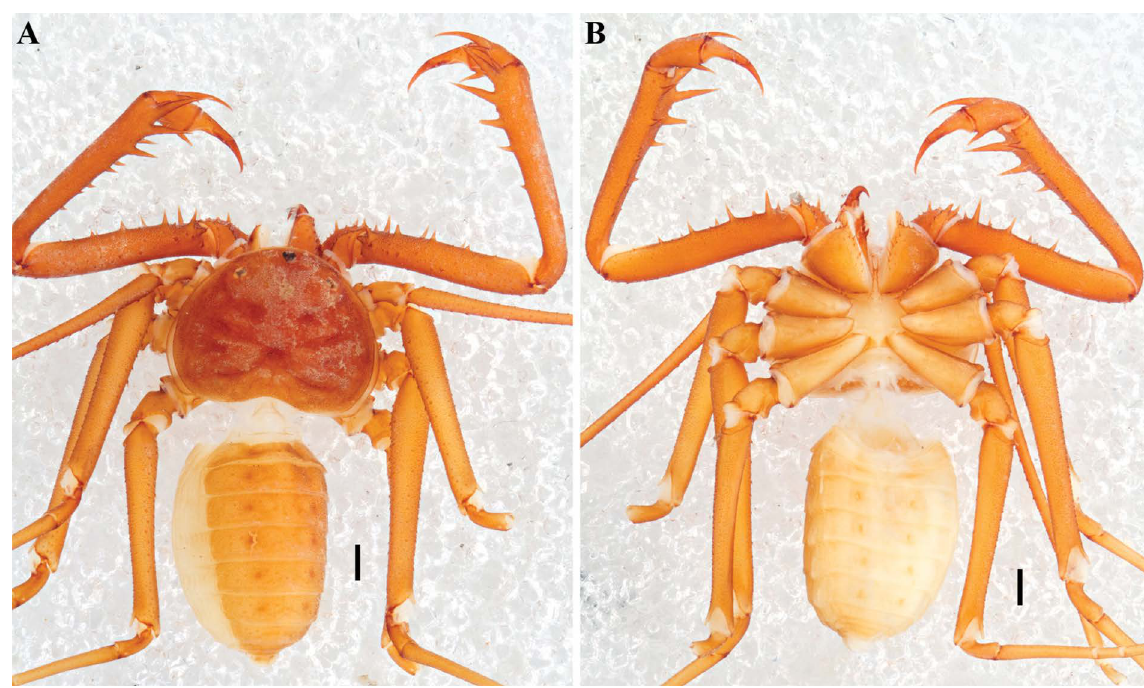
Fig. 81. Charinus madagascariensis Fage, 1954 (MNHN), habitus, ♂. A . Dorsal view. B . Ventral view. Scale bars: 1